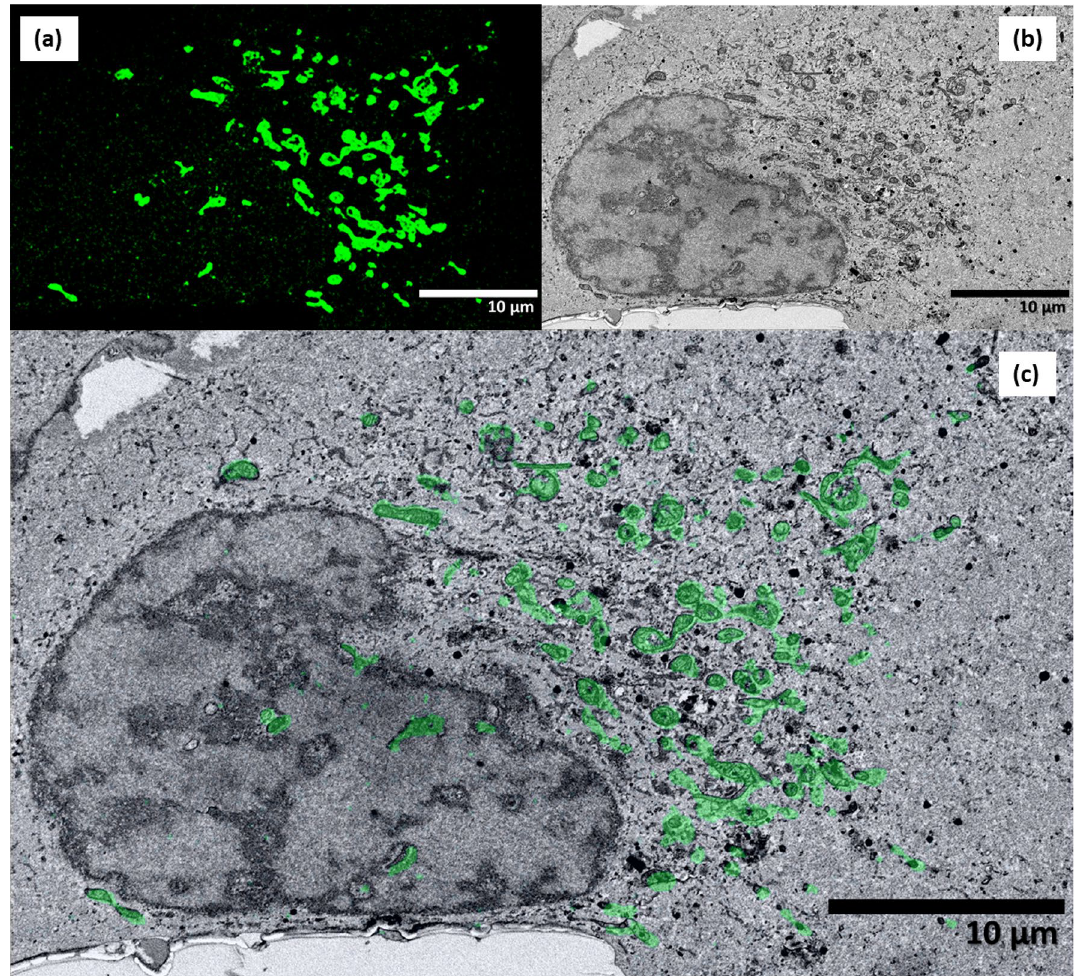
Figure 7. Two-dimensional projection of iPALM-imaged single U2OS cell with outer mitochondrial membrane immunolabeled with TOMM20 ( a ). Single SEM of a single slice of the OSSM process where ultrastructural detail in the cell is evident ( b ). Overlay of the 2D iPALM projection onto the single OSSM slice showing a correlation between mitochondrial structures and the TOMM20 label ( c